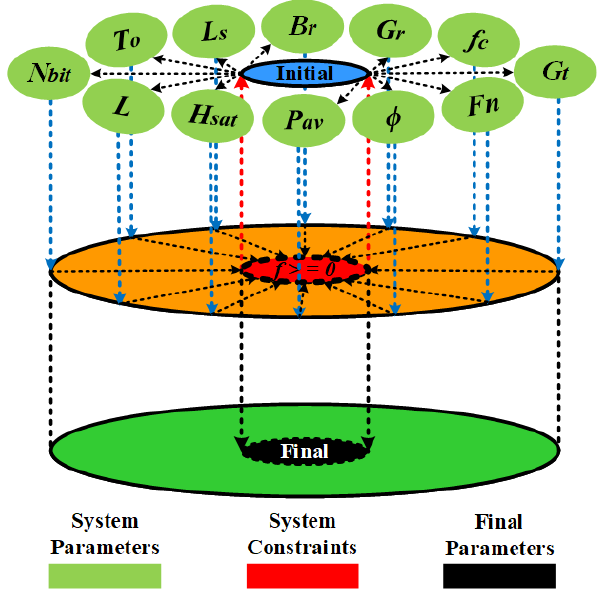
Figure 2. Schematic diagram of SAR system design for lunar water ice exploration. The blue, red, black, and light green ellipses represent the initial parameter values, constraint, final parameter values, and system parameters, respectively, and the orange circle denotes the calculation of the SAR system